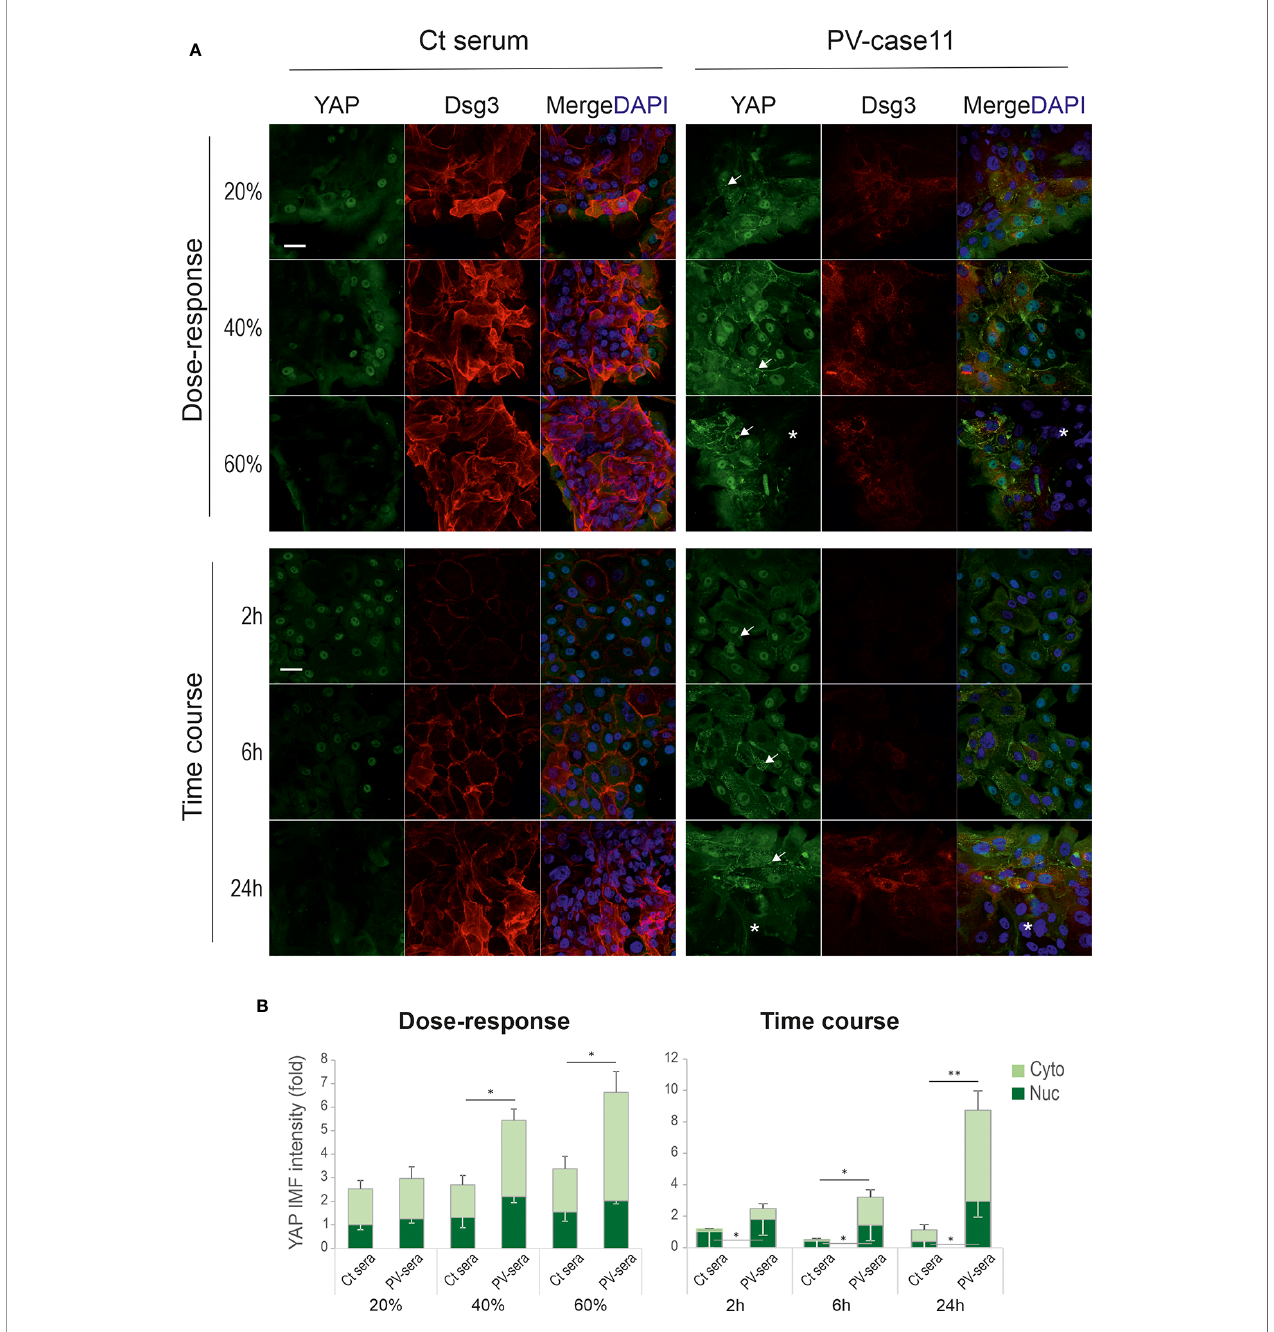
FIGURE 3 | Primary human skin keratinocytes treated with PV serum also show aberrant YAP expression. (A) Confocal images of primary human skin keratinocytes double labeled for YAP and Dsg3. Cells were seeded at ~60% con fl uent densities (~2.5x105/well) in KSFM for one day before treated with different doses of PV sera at 20%, 40% and 60% for 24 hours (top panels) or 40% for 2, 6 and 24 hours (bottom panels), respectively, in calcium-containing KSFM. For the dose experiment, cells were exposed to PV serum in KSFM (low Ca++) overnight. Then the serum media were changed to high calcium-containing (1.8mM) KSFM, and cells were incubated for additional 6 hours before fi xation (total 24 hours). For the time-course experiment, cells were treated with PV serum in calcium-containing KSFM (Ca ++ , 1.8mM) for various time points before fi xation. Notably, cells were sensitive to calcium-containing medium and with a greater degree than N/TERT cells. In control cells, strong YAP nuclear staining was displayed at the edge of the colonies coupled with faint diffuse cytoplasmic signals. In contrast, cells treated with PV serum showed increased YAP with membrane distribution and cytoplasmic aggregates (arrows). Reduced YAP signals were detected in the colonies ’ central areas, especially in samples of 60% PV sera treated cells and 40% PV sera treated cells for 24 hours (asterisks). Reduction of Dsg3 staining was evident in PV serum treated cells compared to the respective controls. (B) Image quanti fi cation for those shown in A (normalized to control nuclear signal that was arbitrarily set as 1) (n=5 fi elds/sample, mean ± SEM, *p<0.05, **p<0.01). Scale bar,